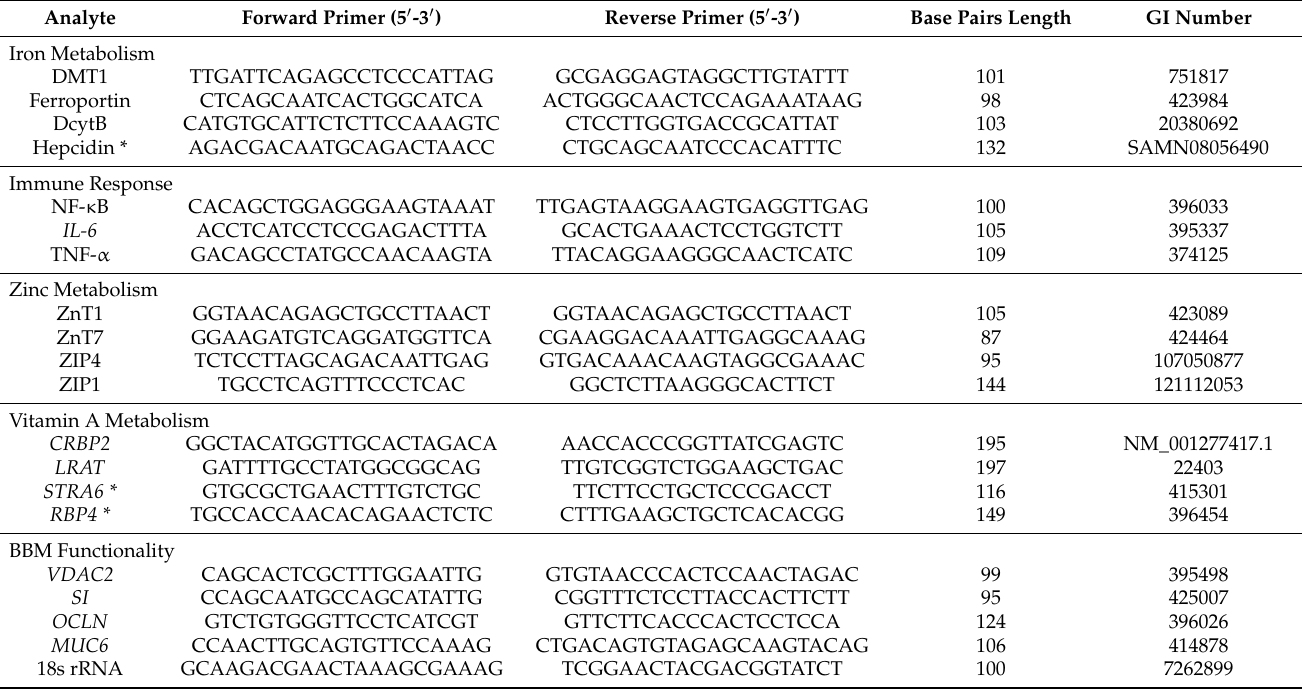
Table 1. The sequences of the primers (both forward and reserve) used in this study are displayed. GenInfo Identifier number and base-pair lengths have also been specified. All were assessed in the duodenum except for those represented by * these were assessed in the